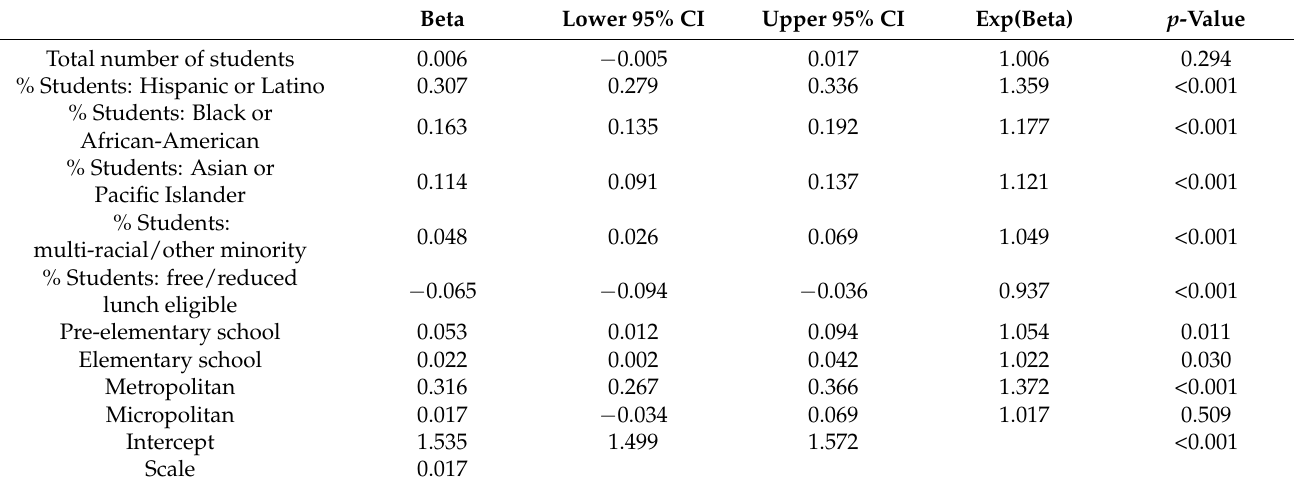
Table 3. Multivariable generalized estimating equation (GEE) for predicting NO 2 exposure in Texas public